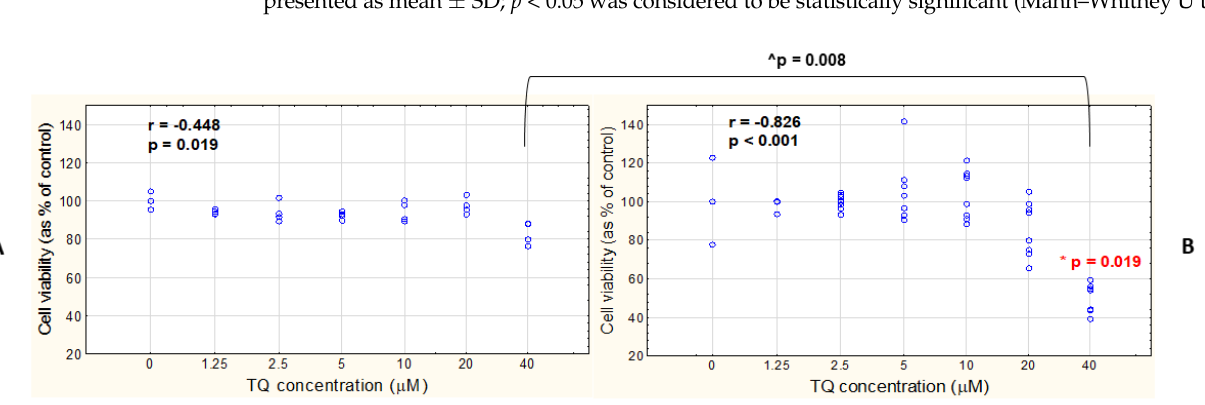
Figure 7. WM9 cells show higher sensitivity to antiproliferative effect of TQ. Assessment of cytotox- icity (WST-1) in the two melanoma cell lines: A375 ( A ) and WM9 ( B ) treated with different concen- trations of free TQ for 48 h. Spearman correlation analysis of the data shows the relationship be- tween TQ concentration and cell viability. Spearman correlation coefficient (r) and p -value are shown; * denotes significant differences between the TQ-treated cells and DMSO control (presented as o  M TQ concentration) (Mann – Whitney U test); ^ denotes significant differences between the two analyzed cell lines (Mann – Whitney U test); data are presented as mean ± SD; all the results were considered statistically significant when p < 0.05.